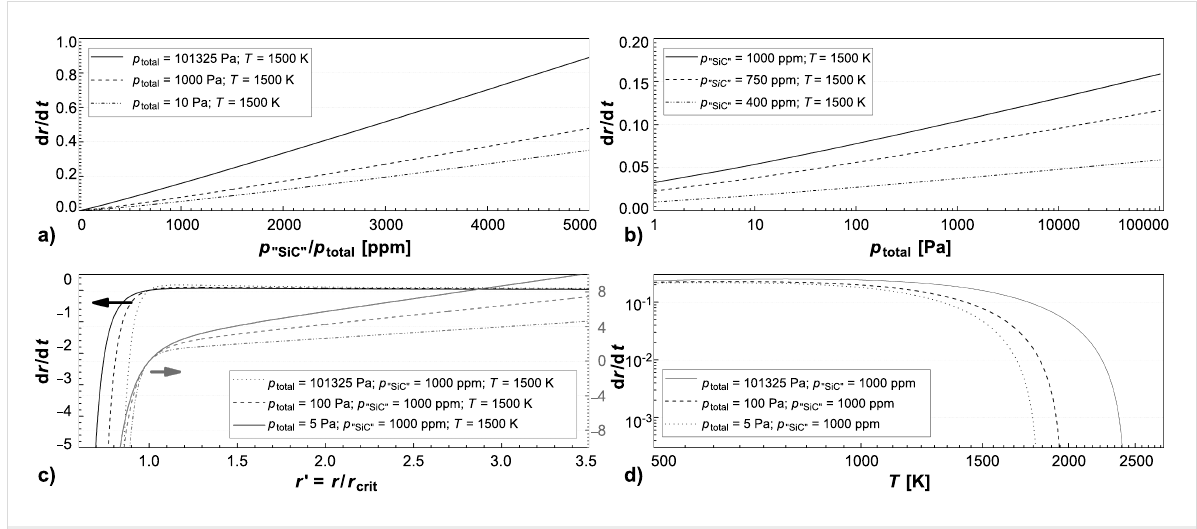
Figure 2: Visualisation of the relation between the growth d r/ d t and the different variables from Equation 2. The growth rate d r /d t a) depends linearly on the concentration of the precursor species c precursor ≡ p "SiC" / p total , b) is a linear function of the logarithm of the pressure, when the concentration of the precursor species is kept constant, c) increases linearly with the particle volume V for particle sizes above the critical radius r crit (cf. Equation 1), and d) shows only a small dependency for low temperatures but decays rapidly for higher